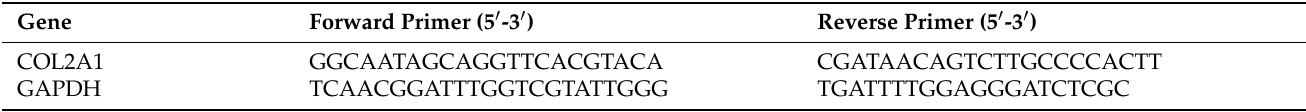
Table 1. Sequence of primers used for RT-PCR studies. Gene Forward Primer (5 (cid:48) -3 (cid:48) ) Reverse Primer (5 (cid:48) -3 (cid:48)